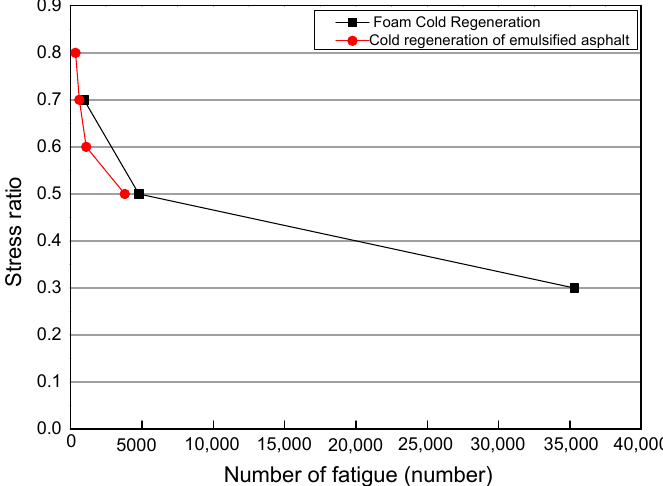
Figure 10. Comparison of emulsified asphalt cold recycled mixtures and foamed asphalt mixtures.